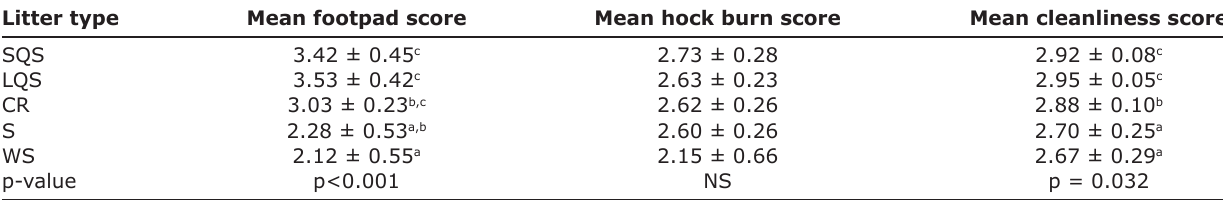
Table-1: Effects of litter type on average score of footpad, hock burns, and plumage cleanliness in broilers at 42 days of age. Litter